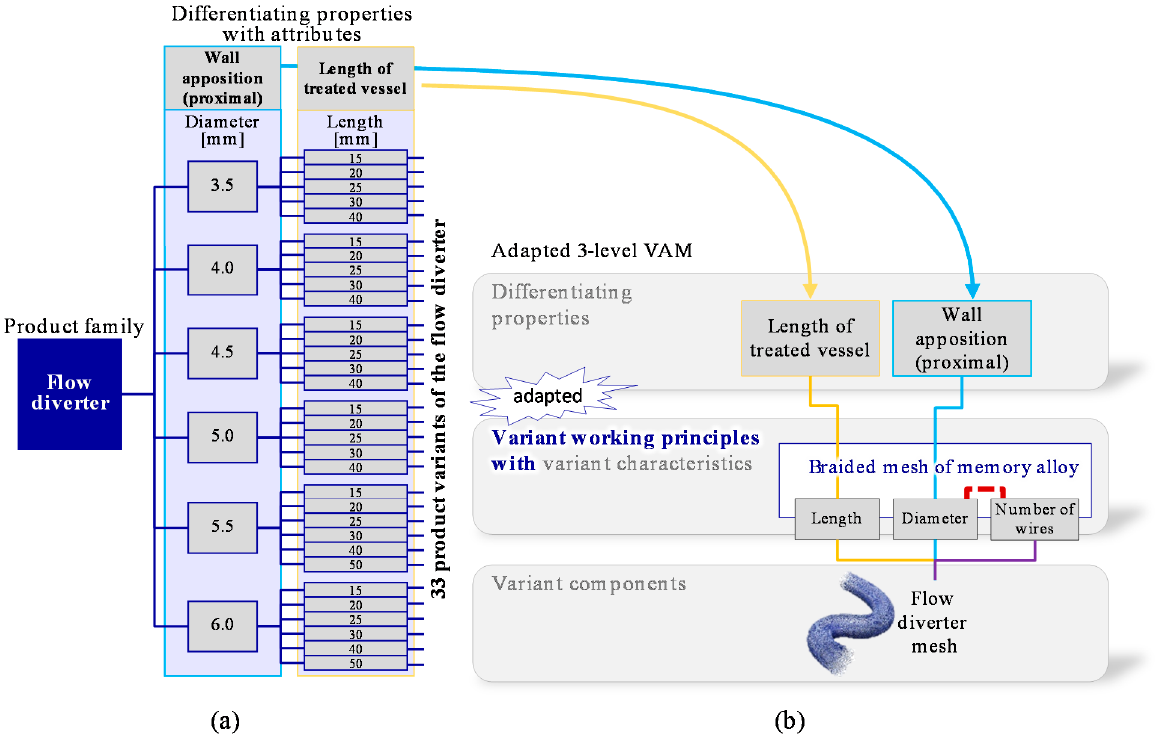
Figure 6. ( a ) External variety of the flow diverter presented in a TEV ; ( b ) Internal variety of the flow diverter presented in a VAM with three levels.